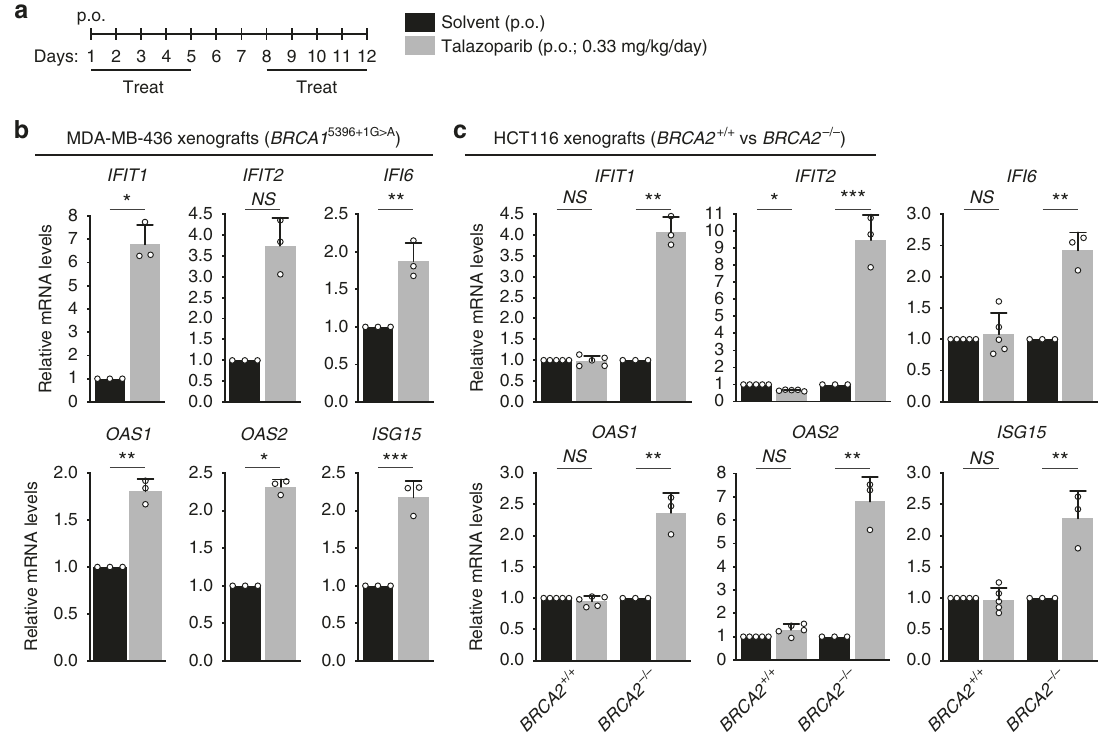
Fig. 6 Effect of PARP inhibitor on ISG expression in BRCA1/2-de fi cient tumors. a Schematic representation of tumor treatment. Tumor-bearing mice were treated on indicated days with PARP inhibitor talazoparib or with solvent control, both orally administered (p.o.). Total RNA was prepared from tumors collected at the end of the treatment. b BRCA1-de fi cient MDA-MB-436 human cells (1 × 10 6 ) were injected into the mammary fat pad and c HCT116 ( BRCA2 + / + or BRCA2 − / − ) human cells (3 × 10 6 ) were injected intramuscularly into the hind leg muscles of CB17/SCID mice and allowed to generate tumors which were then treated as in ( a ). mRNA levels of indicated genes were determined using quantitative RT-PCR analyses and were expressed relative to the gene encoding β -actin ( b ) or GAPDH ( c ) and to solvent-treated control tumors (2 − ΔΔ CT ). Error bars represent SD of n = 3 ( b , c BRCA2 − / − ) or n = 5 ( c , BRCA2 + / + ) tumors, for which quantitative RT-PCR reaction was performed in triplicates. NS , p > 0.05; *, p < 0.05; **, p < 0.01; ***, p < 0.001 (unpaired two-tailed t